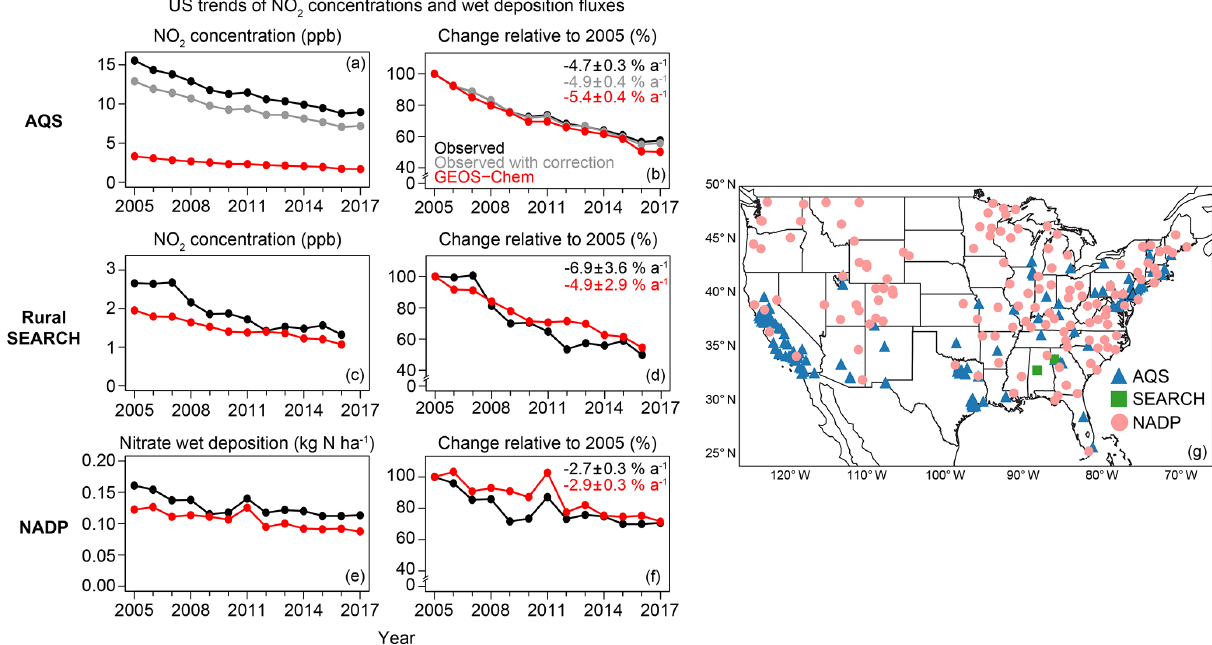
Figure 2. The 2005–2017 trends in annual mean surface NO 2 concentrations and nitrate wet deposition fluxes over the contiguous US. Observations are compared to GEOS-Chem model values sampled at the corresponding sites. The map in the right panel (g) shows the obser- vation sites for the AQS, SEARCH, and NADP measurements networks with continuous annual records for 2005–2017 (2016 for SEARCH). Panels (a) and (b) show surface NO 2 observed at AQS sites (mainly urban). The measurements are affected by positive interference from NO x oxidation products and the gray line shows the data corrected as in Lamsal et al. (2008). Panels (c) and (d) show surface NO 2 at the two rural SEARCH sites in the southeastern US. Panels (e) and (f) shows nitrate wet deposition fluxes at NADP sites. Panels (b) , (d) and (f) show trends relative to 2005 values and the mean ± standard deviation percent change per year is shown inset. All trends shown are statistically